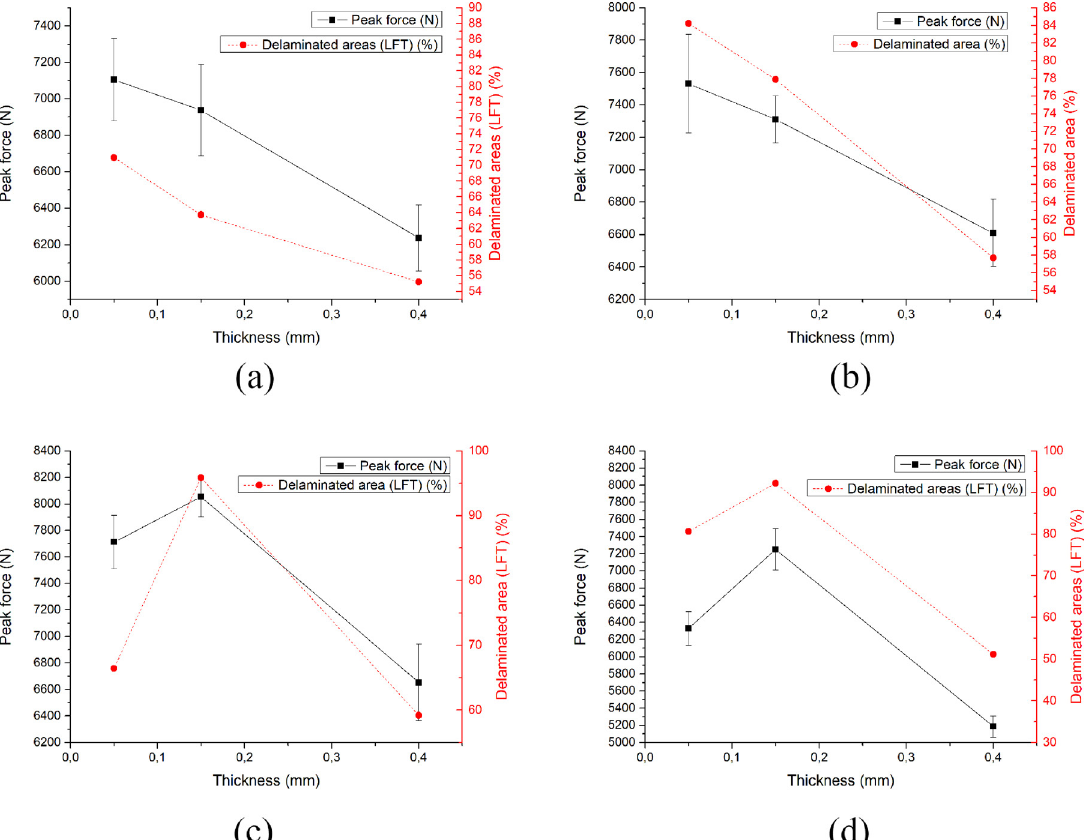
Figure 6. Peak force and LFT failure percentage: (a) Adhesive (b) Adhesive + 0.5 wt% CNT; (c) Adhesive + 1.0 wt% CNT; (d) Adhesive + 2.0 wt%